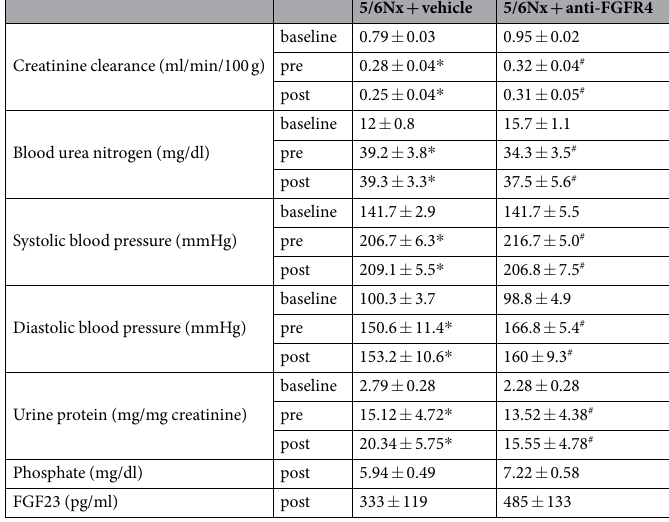
Table 1. Pharmacological inhibition of FGFR4 does not improve kidney function or blood pressure in 5/6 nephrectomized rats. Analyses of renal and metabolic parameters as well as blood pressure in 5/6 nephrectomized (Nx) rats that were performed one week before surgery (baseline), four weeks after surgery (pre) and four weeks after initiation of treatment (post). Compared with 5/6Nx rats receiving vehicle solution, impaired renal function, hypertension, and elevated serum FGF23 levels are not significantly changed by delivery of a FGFR4-specific blocking antibody (anti-FGFR4). Values are reported as mean ± SEM; * p < 0.05 when compared to baseline 5/6Nx + vehicle; # p < 0.05 when compared to baseline 5/6Nx +